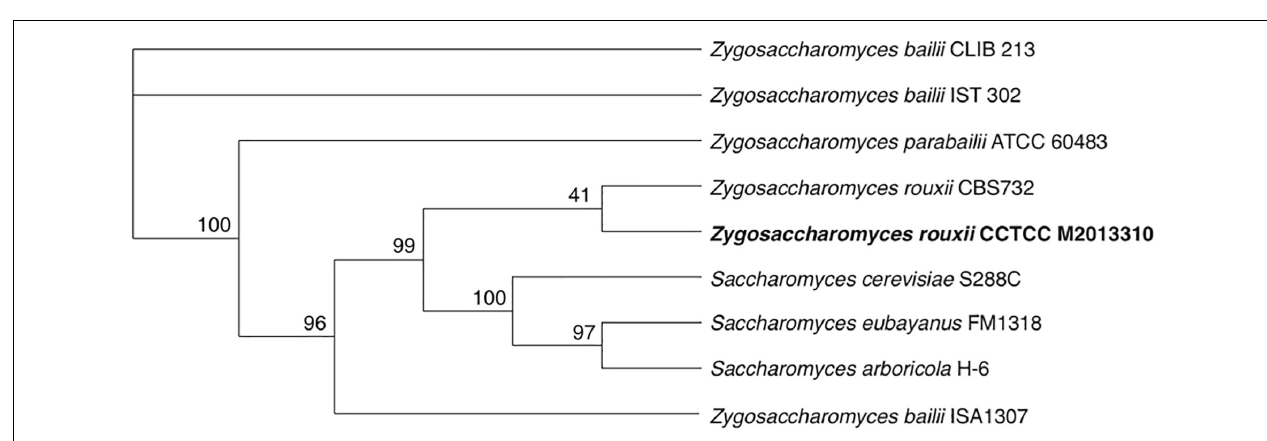
FIGURE 2 | A phylogenetic tree for strain M2013310, as constructed using Orthofinder based on single-copy orthologs.